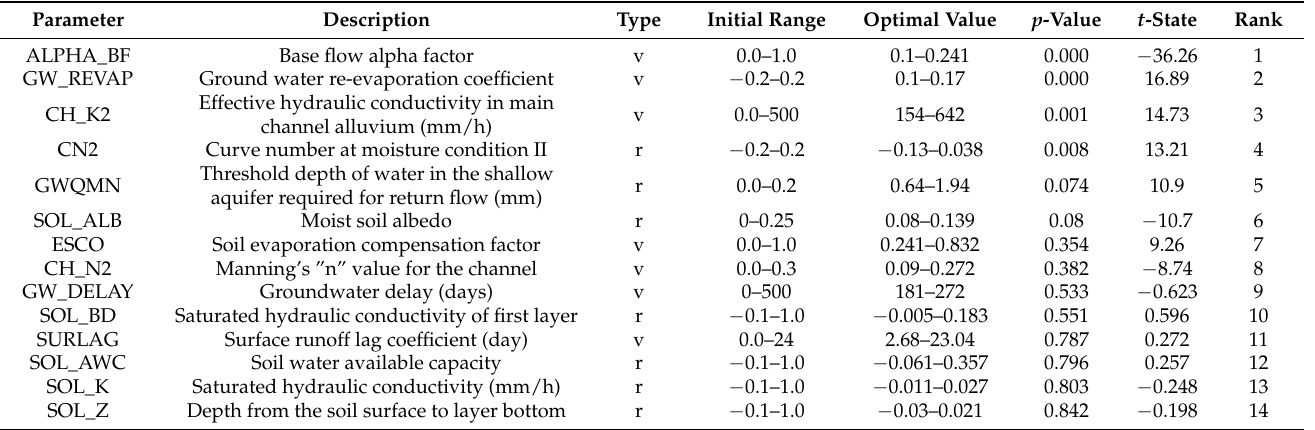
Table 3. Parameters used for calibration with optimum values.